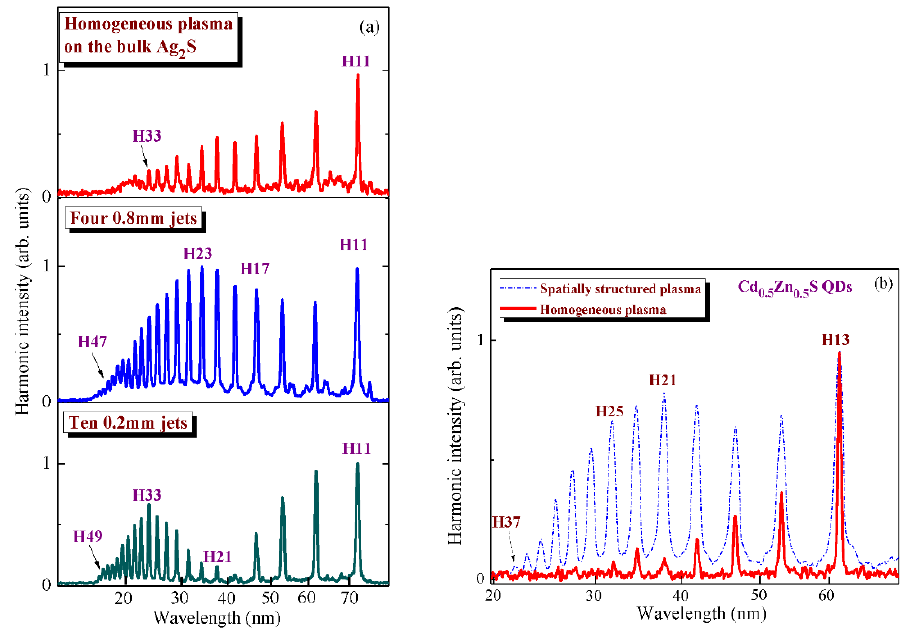
Figure 16. Quasi-phase-matching in ( a ) bulk (Ag 2 S) and ( b ) QD (Cd 0.5 Zn 0.5 S) plasmas. Reprinted with permission from Ref. [49], 2019, American Institute of Physics.